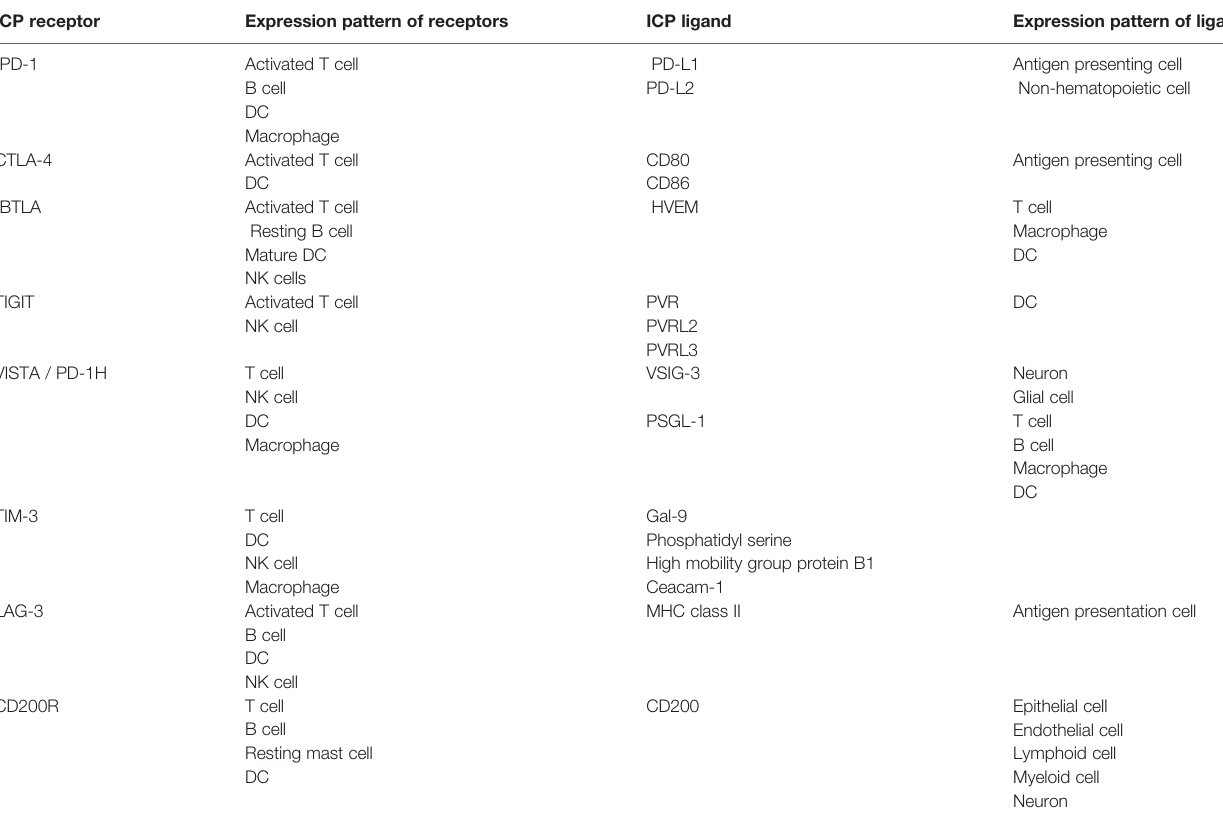
TABLE 2 | Receptors and ligands of immune checkpoints (ICPs). ICP